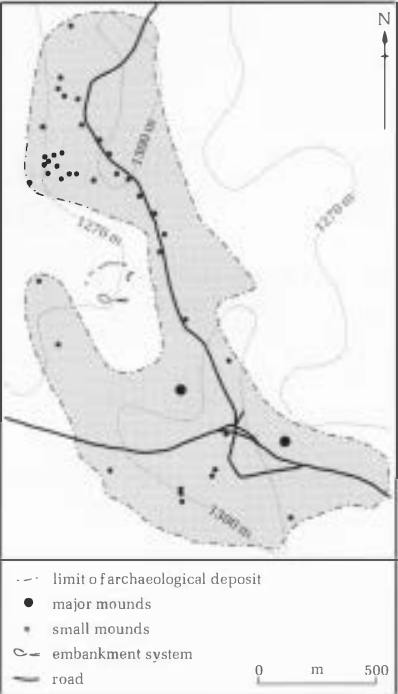
Figure 2 The settlement of Ntusi, south­ western Uganda, showing the distribution of archaeological features. also evident that the cattle-keeping ethos was escalating. A simple division of bone­ size data into earlier and later material shows that the body size of animals was increasing (Fig. 3), presumably as, with increasing expertise, herdsmen selected for larger animals in their choice of breed­ ing